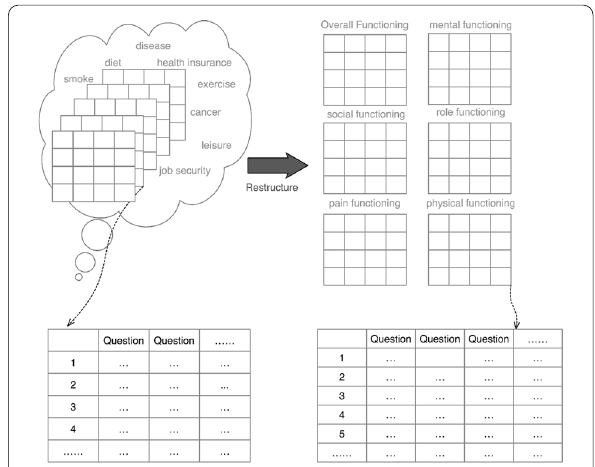
Fig. 3 Data restructure based on psychological